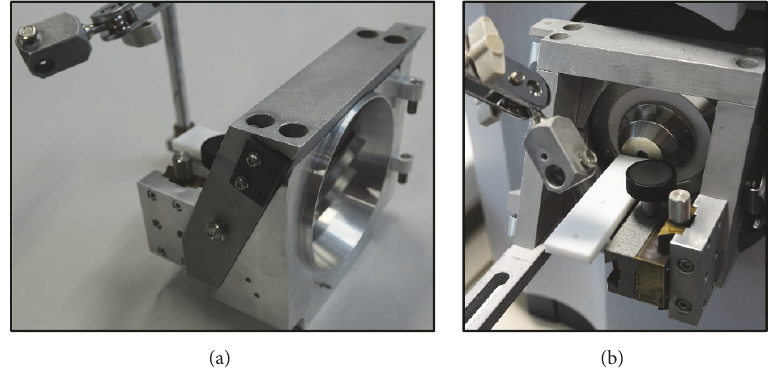
Figure 5: (a) Modular frame for mounting the plasma source to Bruker mass spectrometers and (b) completely mounted to a Bruker